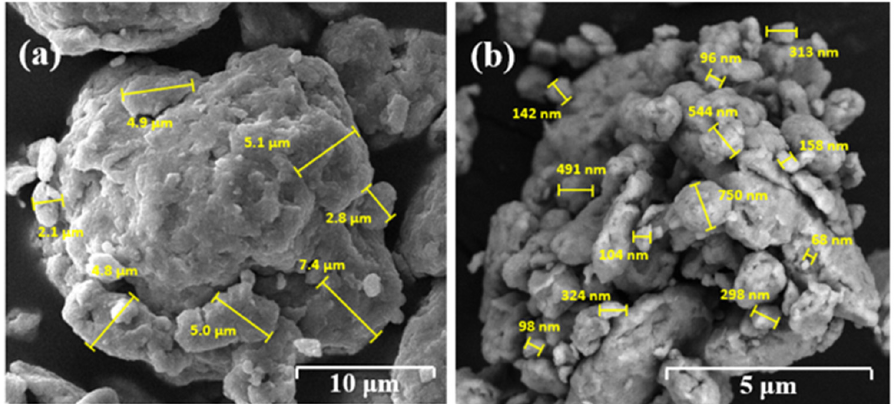
Figure 1. FESEM morphology of ( a ) microcrystalline AlCrFeCoNi HEA powder and ( b ) nanocrys- talline AlCrFeCoNi HEA powder.